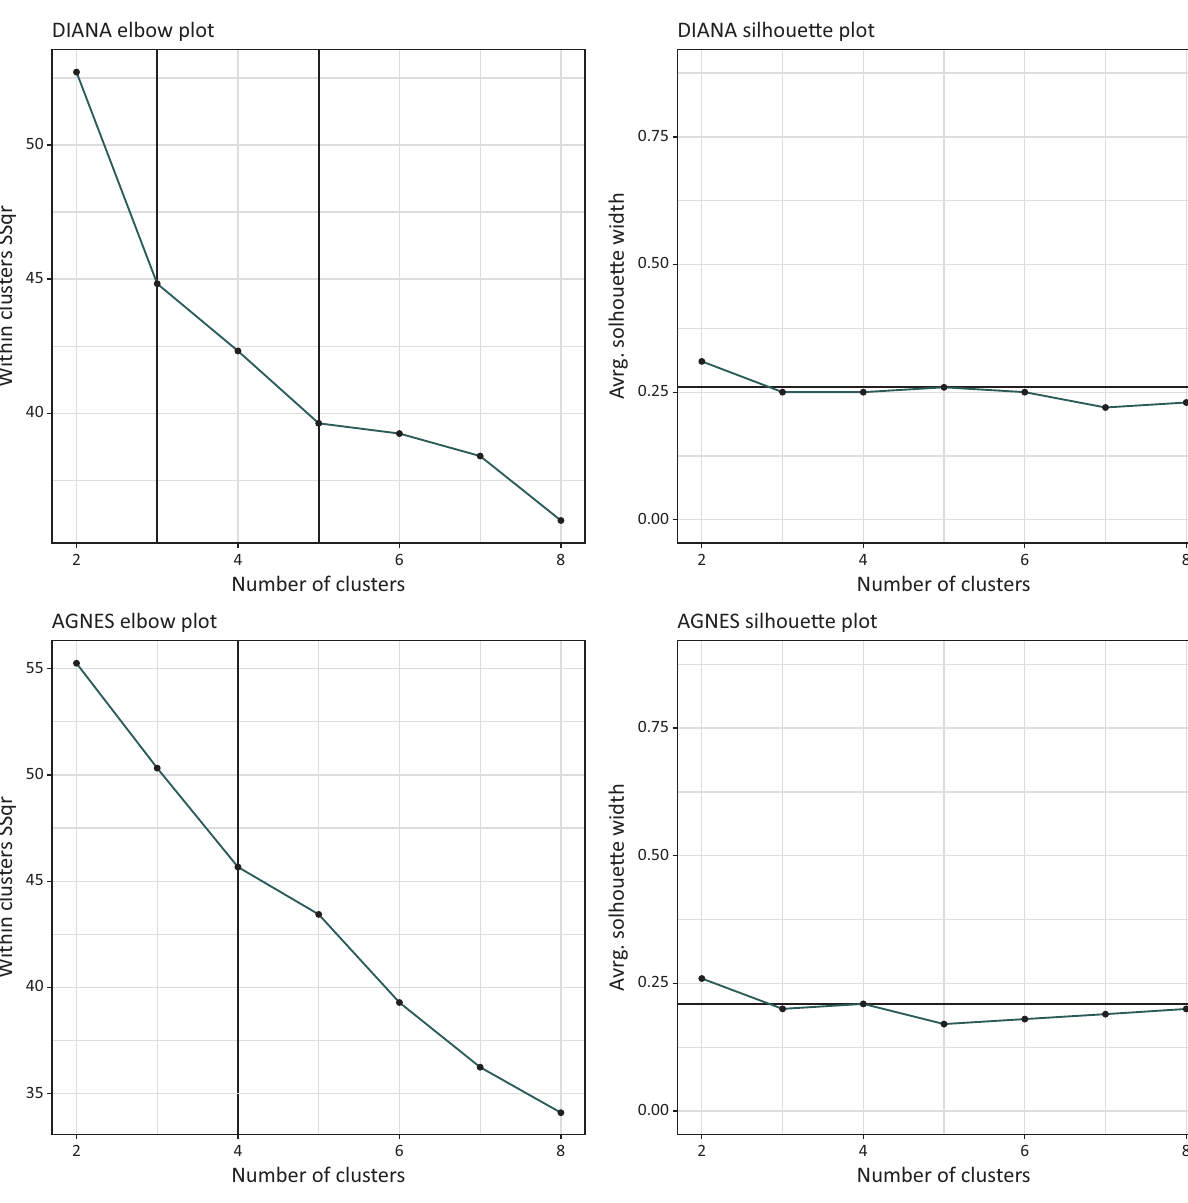
Figure 1. Ellbow and silhouette plots for identifying the optimal cluster solution based on the agglomerative and the divi‐ sive cluster algorithm Notes: Horizontal respective vertical lines mark the best cluster solutions; SSqr = Sum of squares; DIANA = divisive clustering algorithm; AGNES = agglomerative clustering